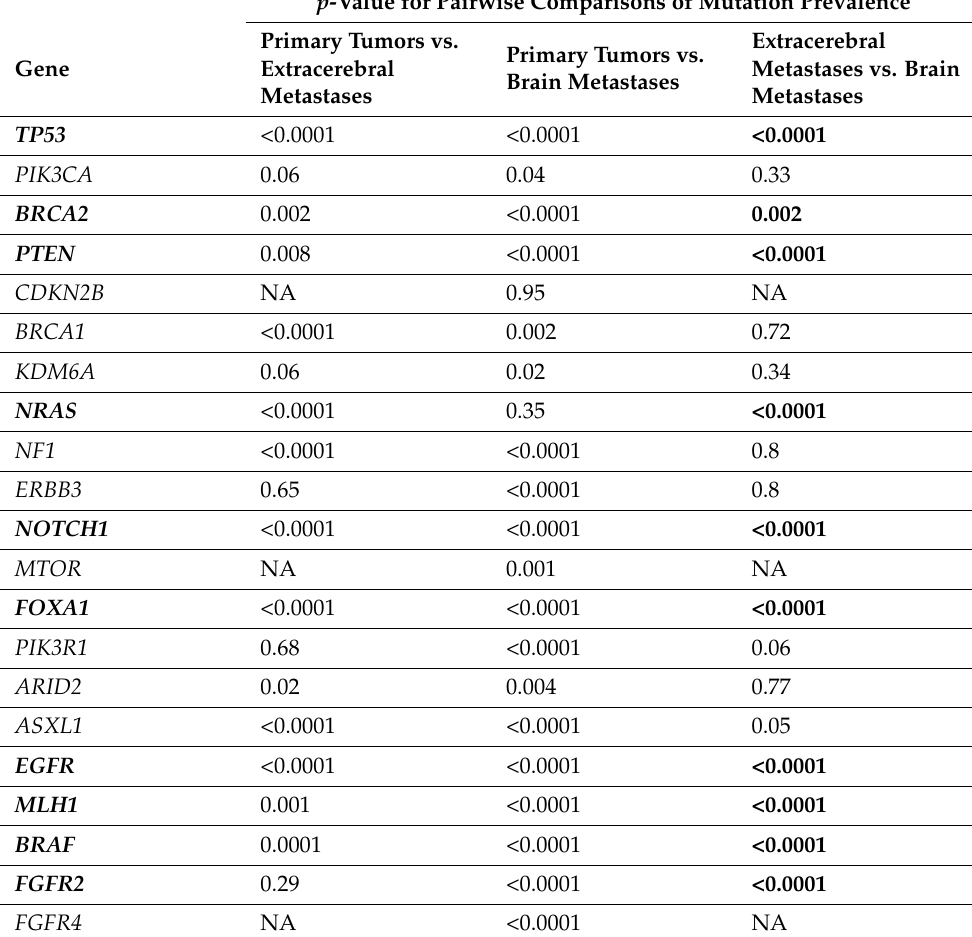
Table 1. Pairwise comparison of prevalence of gene mutations according to the tumor site. Gene